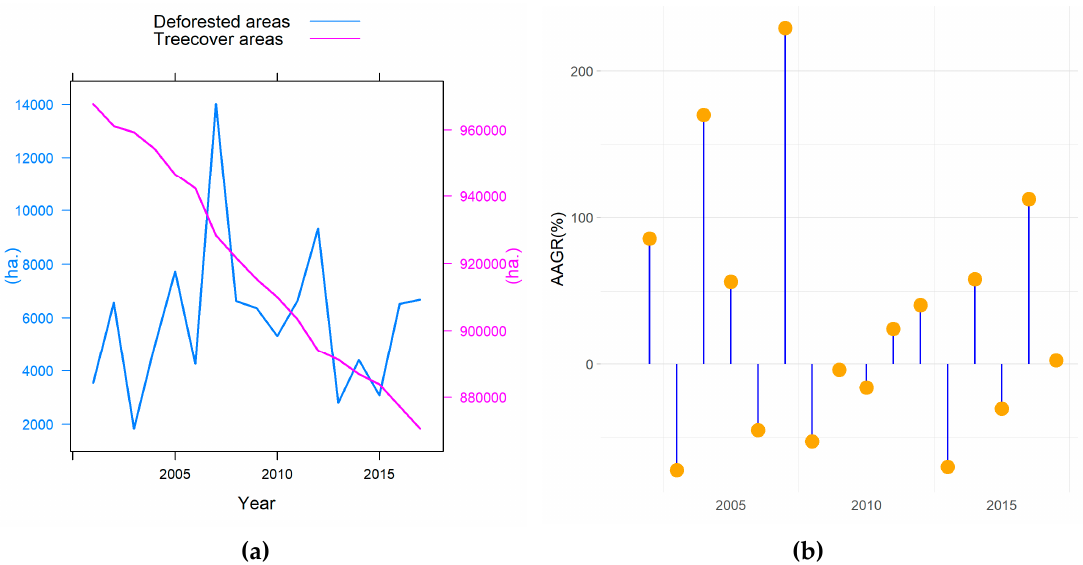
Figure 5. ( a ) Dynamics of tree cover and deforested areas and in the Central Carpathians: the primary y-axis corresponds to the deforested areas in left part and tree cover areas in right part; ( b ) plot representing the Annual Average Growth Deforestation ( AAGDR).